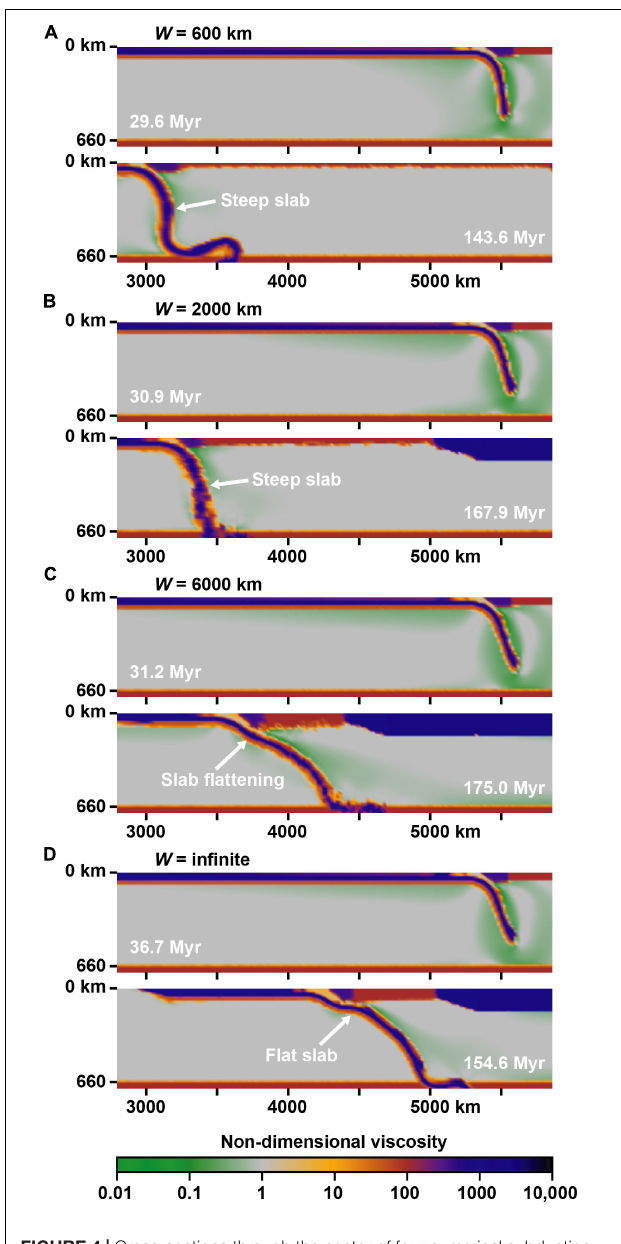
FIGURE 4 | Cross-sections through the center of four numerical subduction models with a different slab width showing two stages in the subduction process (early and late stage). (A) Narrow slab width model ( W = 600 km) showing a steep upper mantle slab. (B) Intermediate-width slab model ( W = 2000 km) showing a steep upper mantle slab. (C) Wide slab model ( W = 6000 km) showing upper mantle slab flattening in a late stage of subduction. (D) Very wide slab model ( W = infinite, 2D set-up) showing flat slab subduction in a late stage of the model evolution. Colors indicate the non-dimensional effective viscosity field. Note that the somewhat fuzzy-blocky appearance of the slab in the lower part of the upper mantle in the bottom panels of (B,C) is the result of the implemented spatial adaptive mesh, which gives a lower resolution in the lower part of the upper mantle compared to the upper part, and the many times that repopulation of cells with particles was required to avoid the occurrence of empty cells. The high number of repopulation exercises, in particular for W = 2000 and W = 6000, caused the boundaries between different particle fields to become progressively fuzzier.